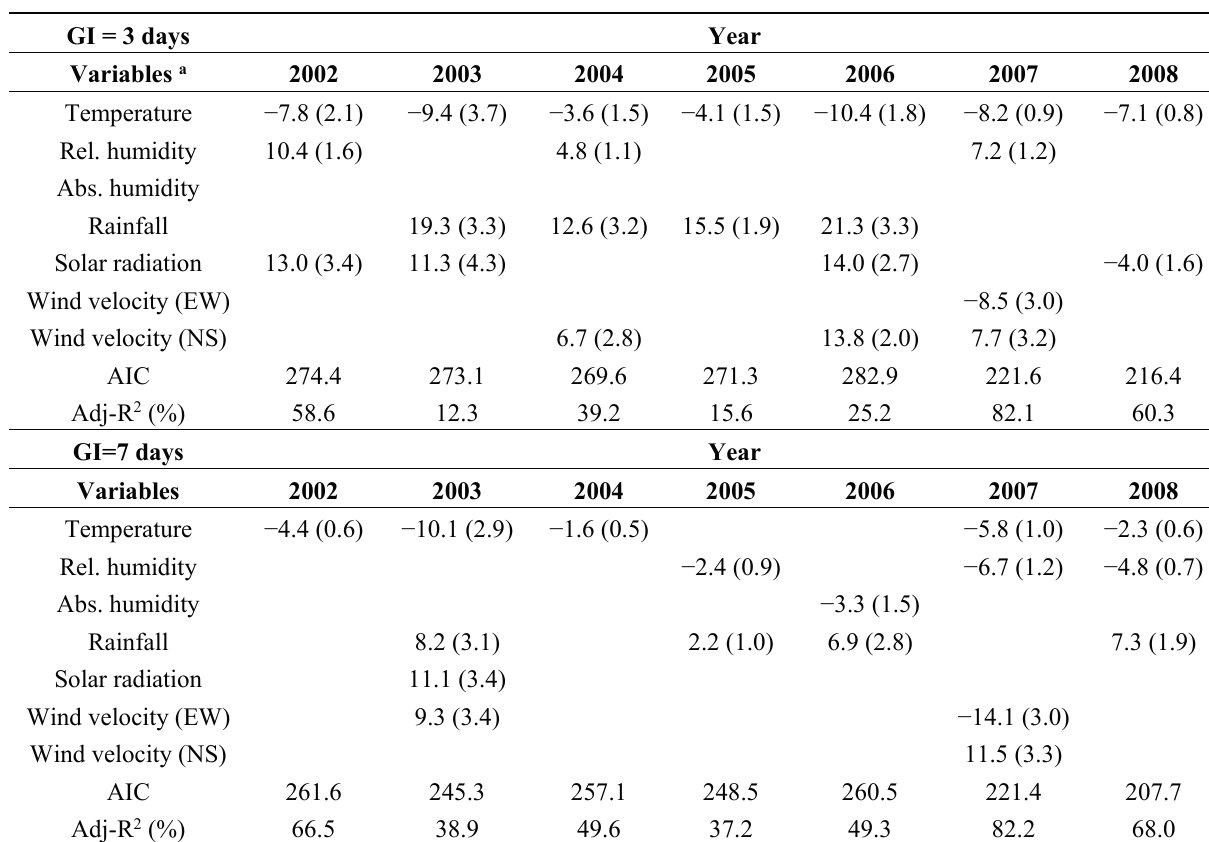
Table 3. Estimates (standard error) of significant meteorological determinants on changes of influenza transmission rate when GI = 3 days or GI = 7